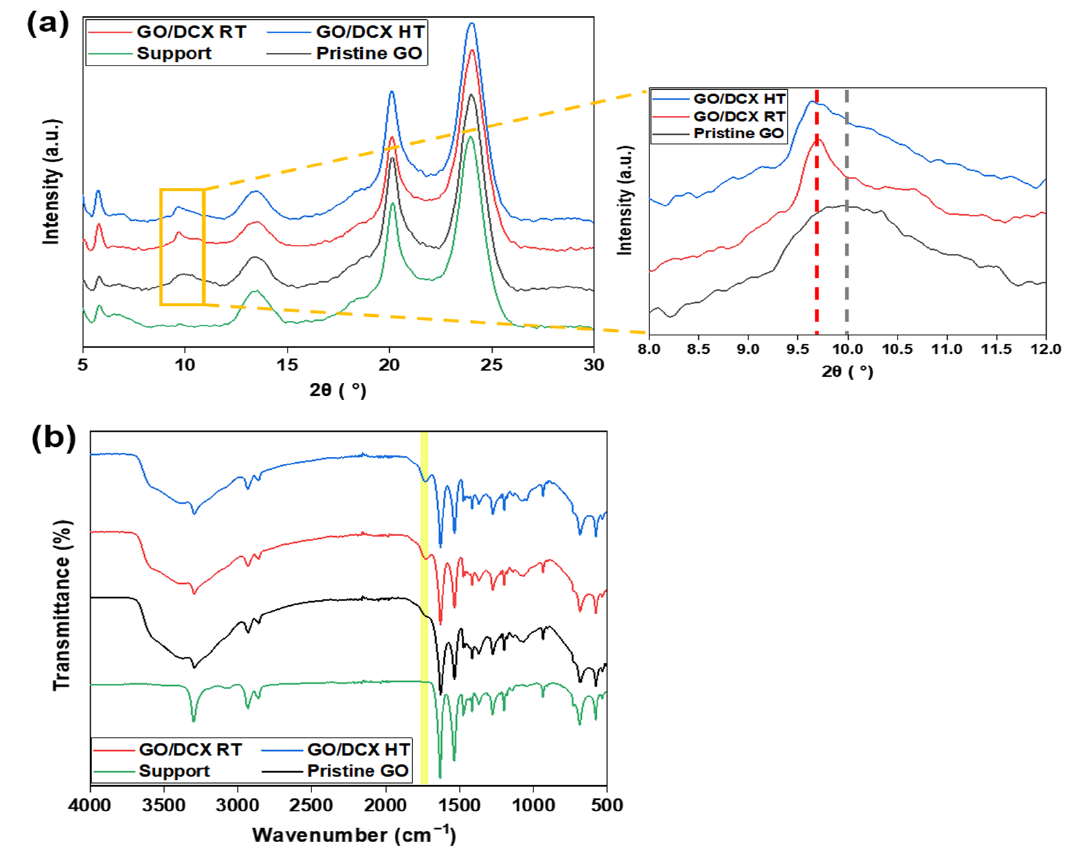
Figure 2. ( a ) XRD patterns of the prepared membranes and the magnified range of 8–12° to compare the differences in the interlayer distances of the GO membranes. ( b ) FT-IR spectra of the prepared membranes.